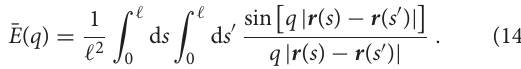
R 2 c . The q − 1 decay, visible =